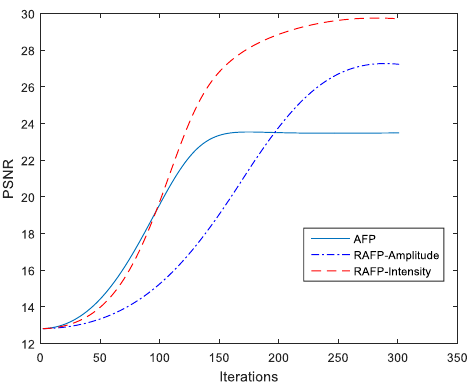
Figure 3. Peak signal to noise ratio (PSNR) for Reweighted Amplitude Flow for Fourier Ptychography (RAFP) algorithm with different weights.